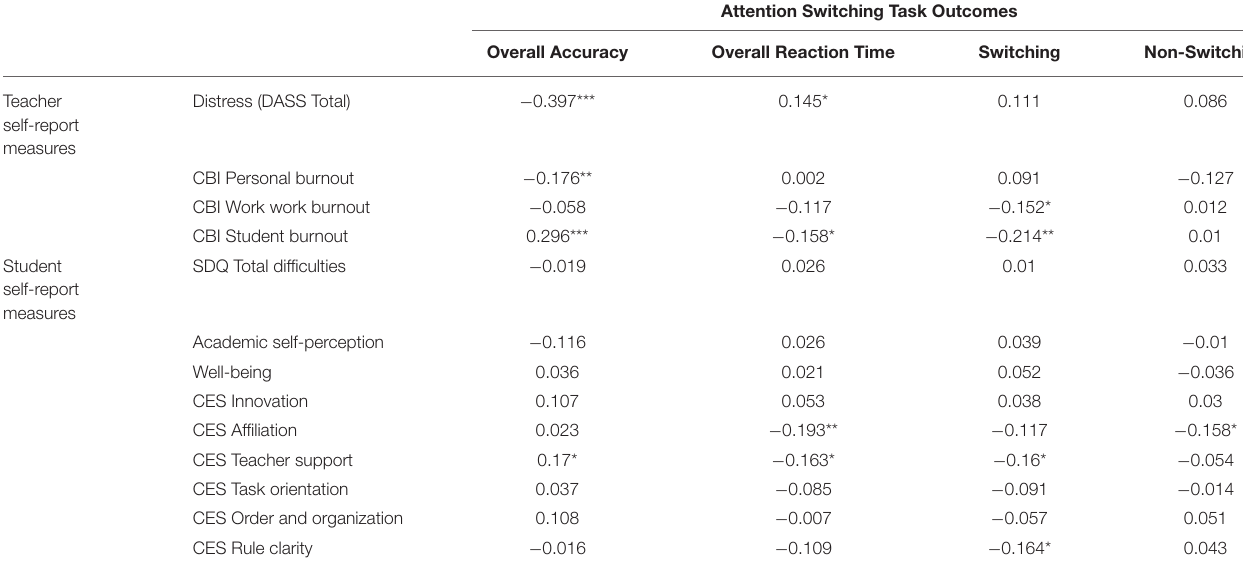
TABLE 4 | Correlations between student and teacher self-report and teacher cognitive